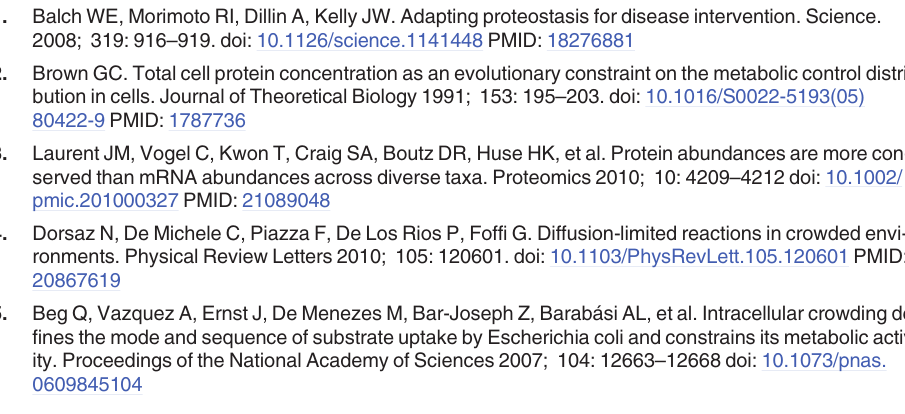
S2 Fig. Glucose as substrate. The shown flux modes correspond to solution ( viii ) in Tab. 3, see also Fig. 5. S3 Fig. Lactate as substrate. The shown flux modes correspond to solution ( xii ) in Tab. 3, see also Fig. 5. S4 Fig. Glucose and lactate as substrates. The shown flux modes correspond to solution ( iv ) in Tab. 4. S5 Fig. Glucose as substrate. The shown flux modes correspond to solution ( viii ) in Tab. 4. S6 Fig. Lactate as substrate. The shown flux modes correspond to solution ( xii ) in Tab. 4. (EPS) S1 Text. Analysis of the minimal example. (PDF) S1 Table. Reaction Names and Parameters. (ODS) S2 Table. MinModes. (ODS) S1 Files. Matlab scripts and model file.